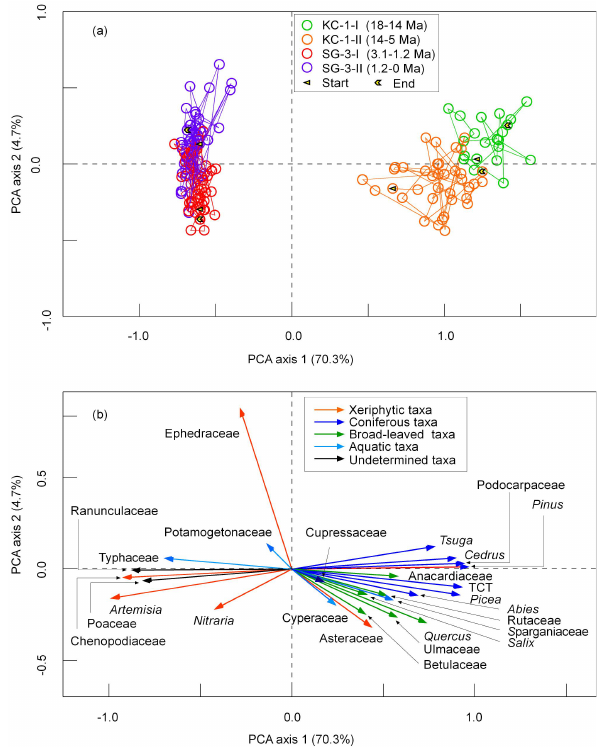
Fig. 6. PCA plot of (a) pollen samples, with pollen zones indi- cated in the KC-1 and SG-3 cores in the western Qaidam Basin (“Start” and “End” represent the first and last samples, respec- tively, in each zone), and (b) pollen types (the end of the arrow indicates the score values of PCA axes 1 and 2; TCT: Taxodi-